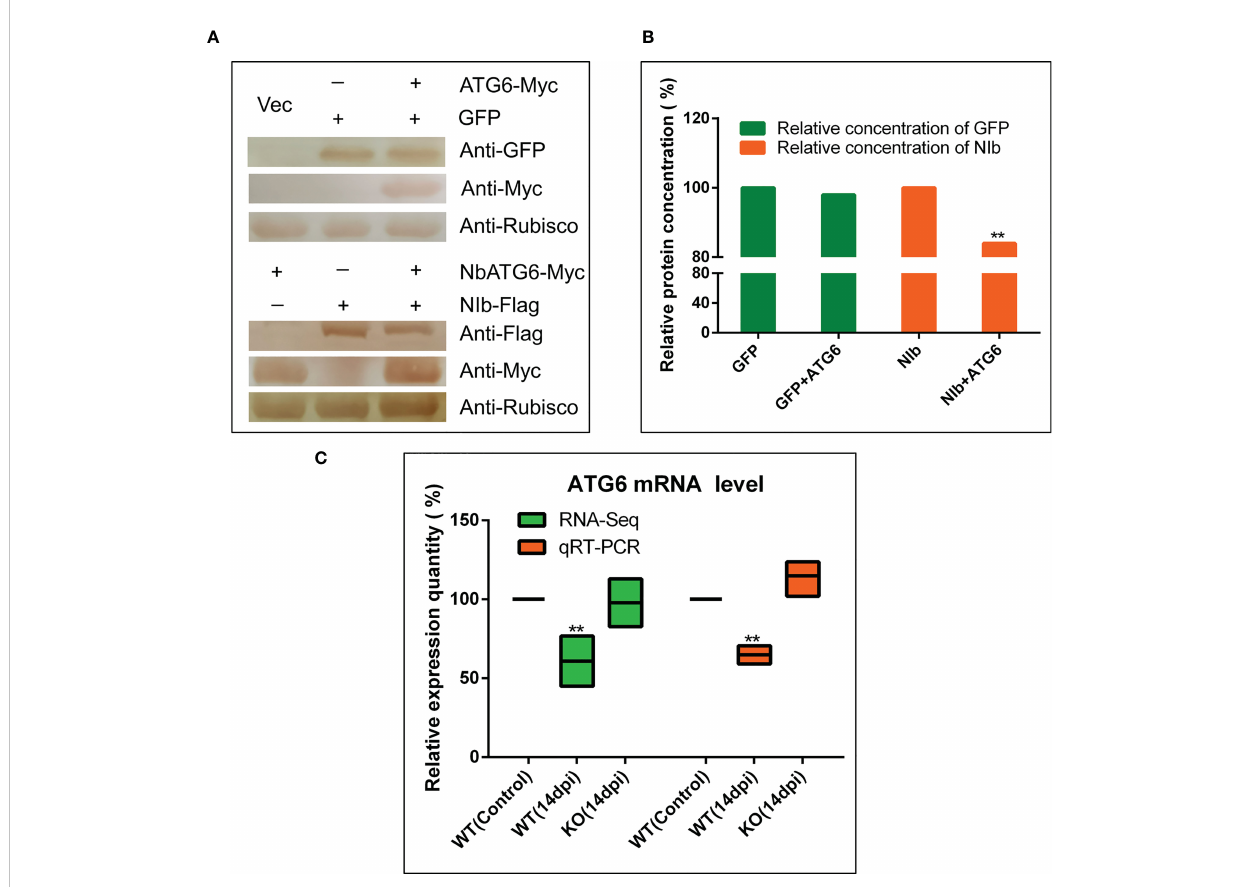
FIGURE 5 NbBI-1 mediated the degradation of NIb by NbATG6. (A, B) NbATG6 degraded PVY NIb. NbATG6, NIb, and GFP were detected by West blot after they co-expressed in plant leaves for 3 days. The western blot detected results were transposed gray and calculated the gray value of these protein bands by photoshop 2020. (C) NbBI-1 mediated the decrease in the expression of NbATG6 caused by PVY infection (qRT-PCR and RNA-Seq). Leaves were collected at 14 dpi. (Student ’ st-test, test, **: